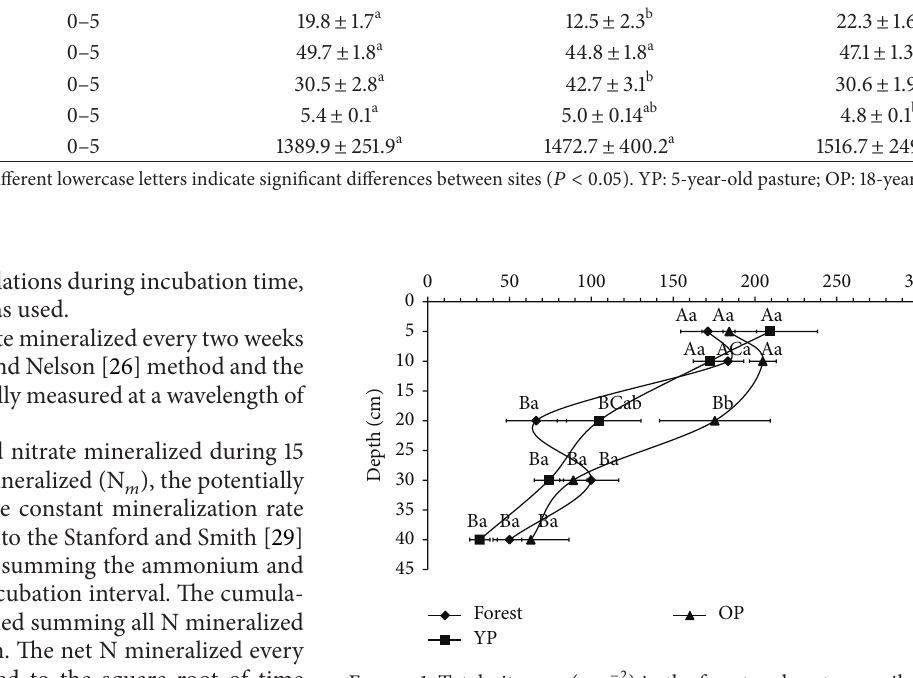
Figure 1: Total nitrogen (gm −2 ) in the forest and pastures soils. All points are mean values with standard error bars across forest and pastures. Different lowercase letters indicate significant differences between sites ( 𝑃 < 0.05 ). Different capital letters indicate significant differences between depths ( 𝑃 < 0.05 ). YP: 5-year-old pasture; OP: 18-year-old